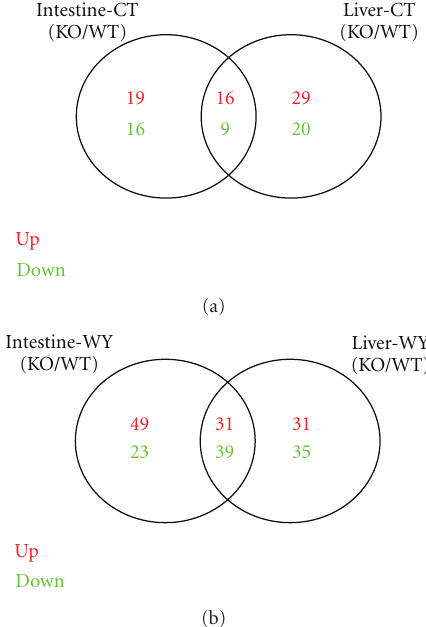
Figure 2: Comparison of PPAR α -dependent regulated pathways between in small intestine and liver of mice. Venn diagram showing the overlapping significantly identified pathways by the comparison of PPAR α -dependent regulated pathways between in small intestine and liver of mice. The studies of Intestine-CT (KO/WT) and Liver- CT (KO/WT) are for identifying PPAR α -dependent pathways; the studies of Intestine-WY (KO/WT) and Liver-WY (KO/WT) are for identifying WY14643 PPAR α -dependent pathways, respectively, in mice small intestine and liver. Pathways of P -value less than 0.01 were considered to be significantly regulated. Red color is for upreg- ulated pathways and green color is for downregulated pathways. In Figure 2(a), there were 16 upregulated and 9 downregulated PPAR α -dependent pathways in common; in Figure 2(b), there were 31 upregulated and 39 downregulated WY14643 PPAR α -dependent pathways in common in both tissues of